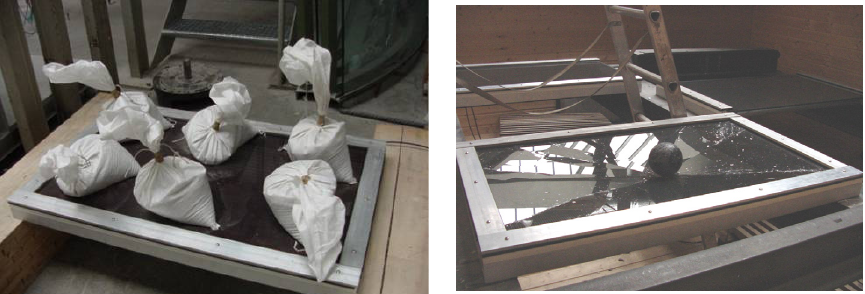
Figure 12: pendulum impact test.